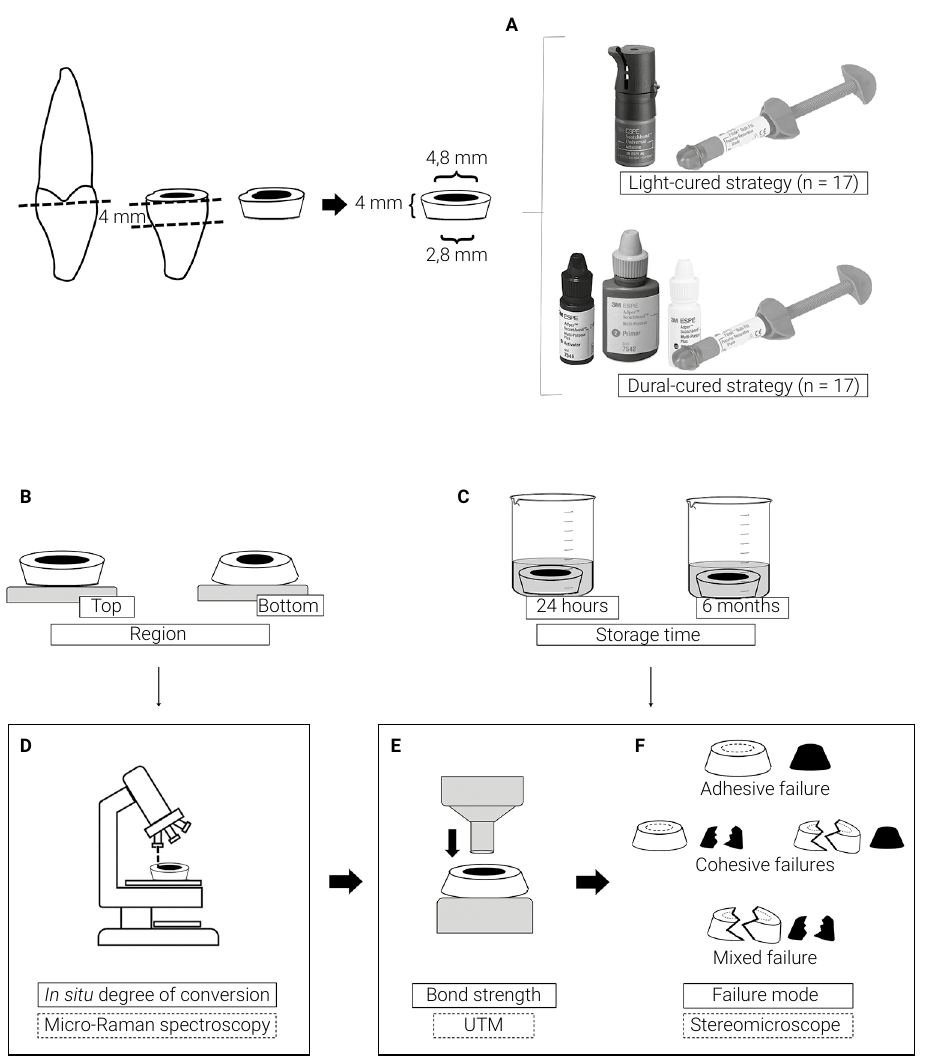
Figure 1. Specimen preparation and groups of curing strategies (A). Regions of specimens (B). Storage times (C). Analysis of the in situ degree of conversion through the micro-Raman spectroscopy (D).